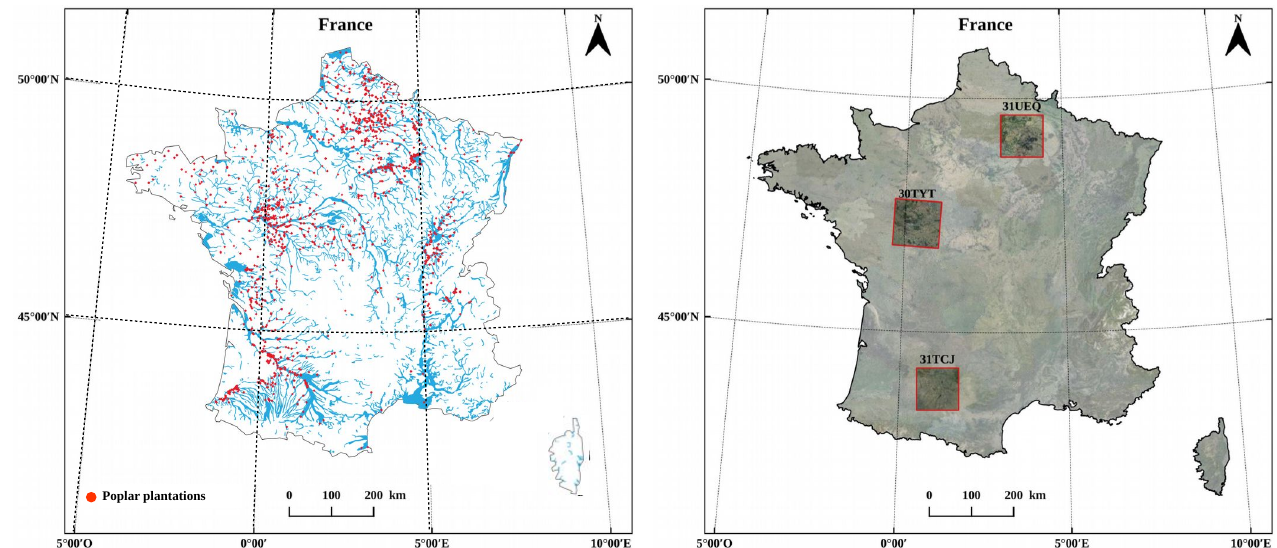
Figure 1. Sentinel-2 image tiles used in this study ( right ): 31UEQ, 30TYT, and 31TCJ. The extent of each tile is displayed as a red square with 100 km sides. S2 tiles are shown in the UTM/WGS84 projection. On the ( left ), the map shows the distribution of poplar plantations (red points) in 2017 estimated from a national sampling by IGN